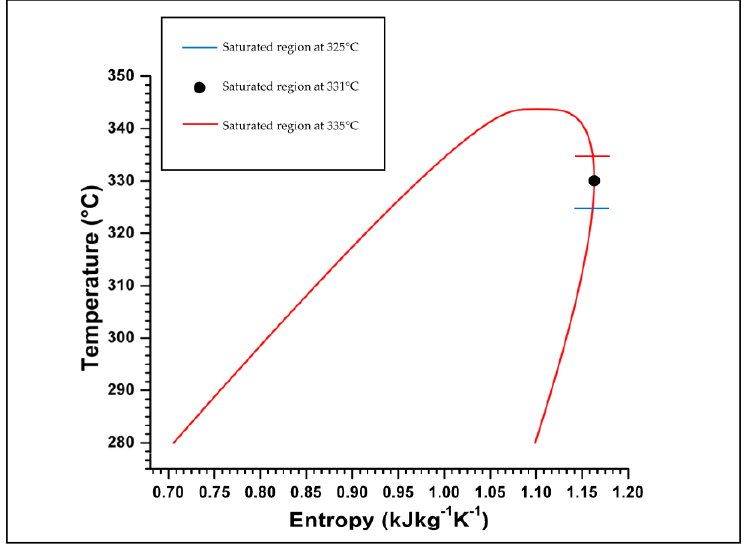
Figure 6. Temperature – entropy diagram of the M - Xylene at the selected region.